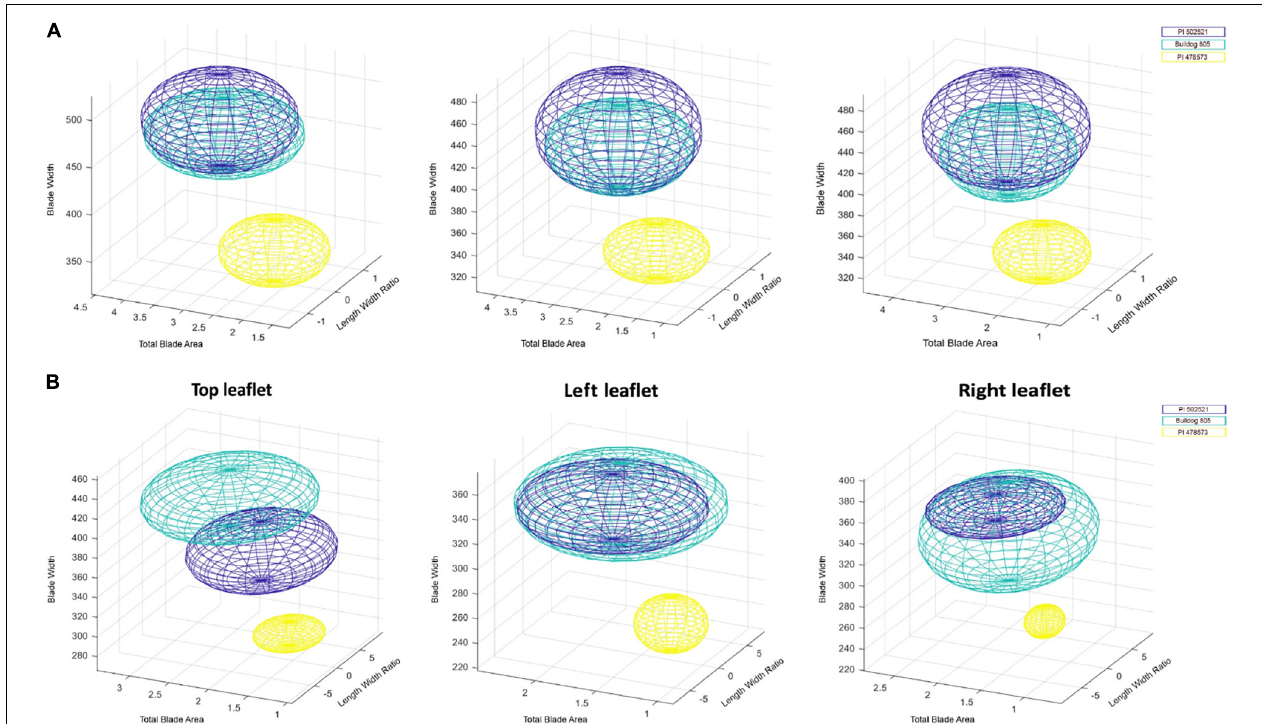
FIGURE 3 | Distribution in the three-dimensional morphospace analysis of leaf groups in alfalfa. Distribution of top, left and right leaf features of alfalfa, PI502521 (dark blue), Bulldog805 (aqua), and PI478573 (yellow) in three-dimensional morphospace defined by blade width, total blade area, and length to width ratio evaluated in Exp. 1 (A) and Exp. 2 (B) under water stress.